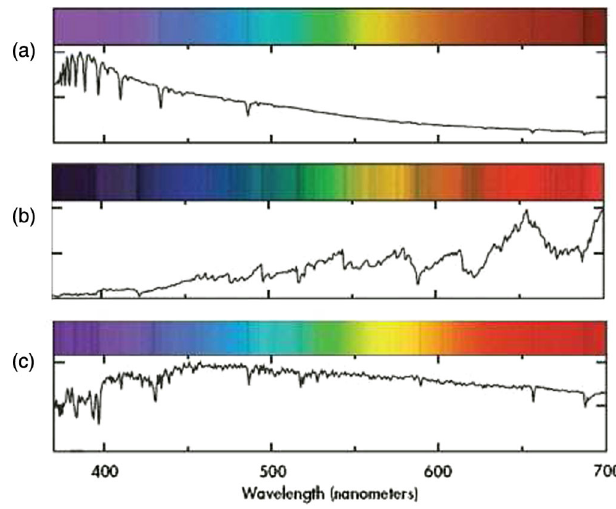
FIG. 7. Spectra: Stellar temperature. Following open-ended question was asked: These are spectra that were obtained from three different stars in our galaxy. Do you think with these spectra images you can arrange them by temperature from hottest to coolest? If so, please do so and explain the reason why you arranged them in such a way. If not, please explain why you can not do with these images.